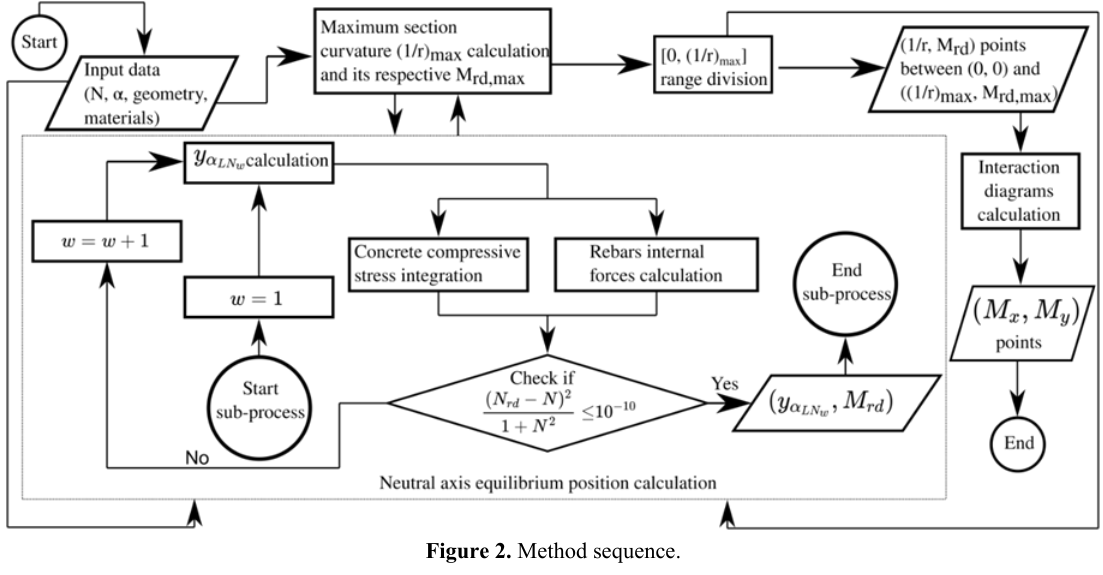
Figure 2. Method sequence.